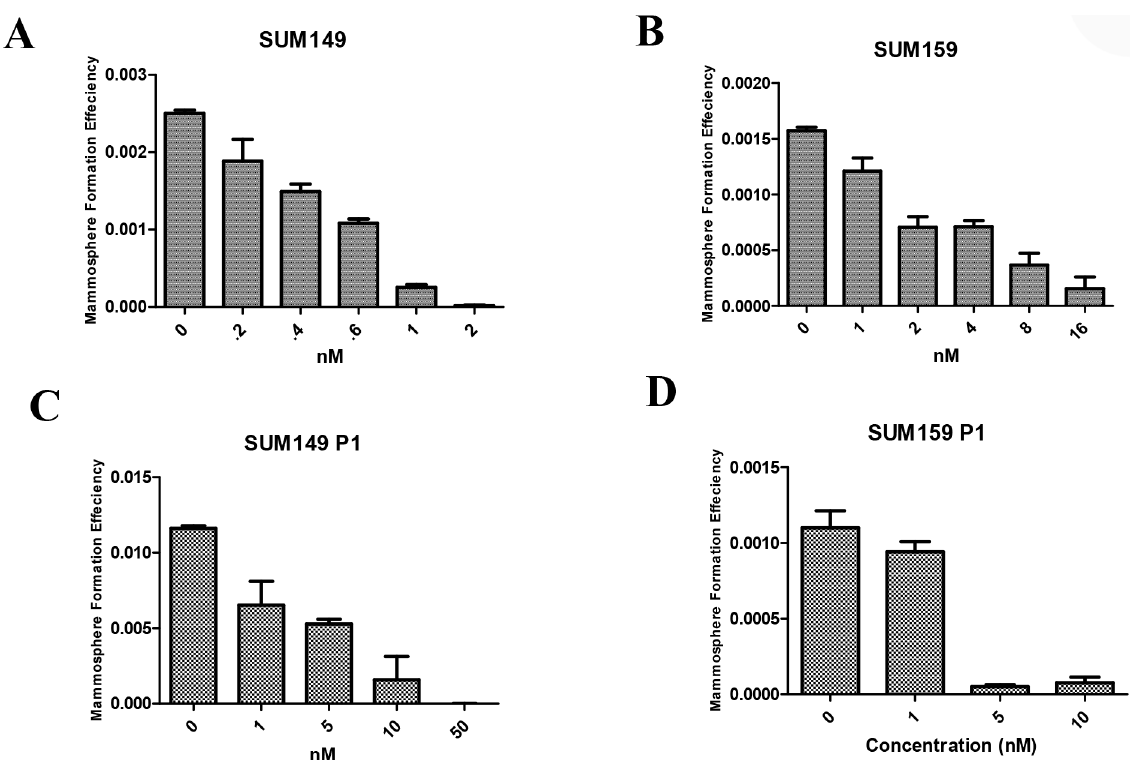
Figure 3. Inhibitory effect of PP on mammosphere formation. (A, B) Primary mammosphere formation. SUM-149 (A) and SUM-159 (B) cells were incubated with indicated doses of PP or DMSO in mammosphere formation media for 7 days. PP treatment reduced the number of primary mammospheres in a dose-dependent manner. (C, D) Secondary mammosphere formation. SUM-149 (C) and SUM-159 (D) cells were grown in mammosphere formation media and treated with indicated doses of PP for 4 days. Then primary spheres were trypsinized and seeded as